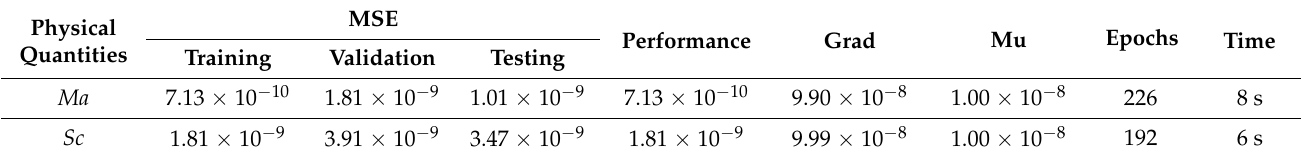
Table 4. Outcomes of LMT-ABPNN for variants of φ ( η ) of